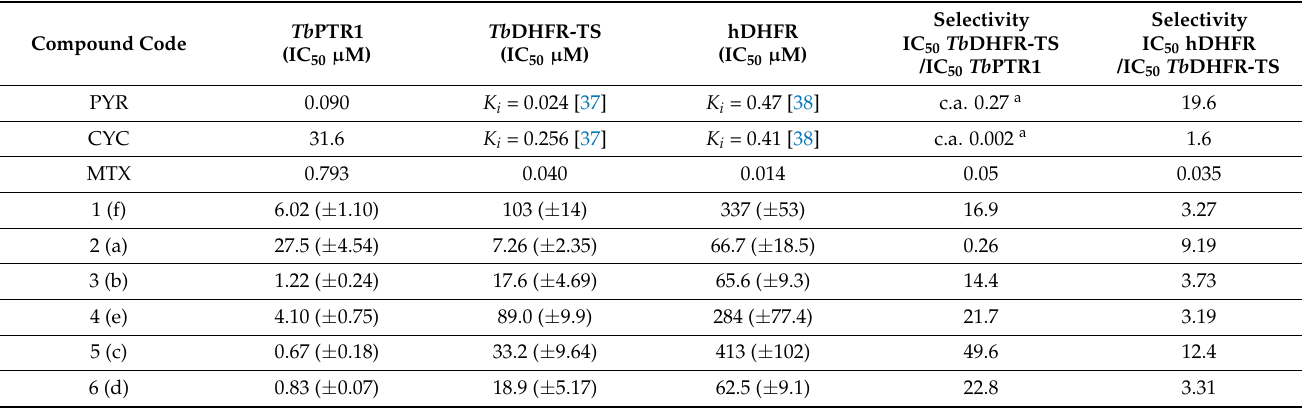
Table 1. Data on inhibition of Tb PTR1, Tb DHFR-TS, and hDHFR by pyrimethamine (PYR), cycloguanil (CYC) methotrexate (MTX) and compounds 1-6 and selectivity index all compounds for IC 50 obtained against Tb DHFR-TS vs Tb PTR1 and hDHFR vs Tb